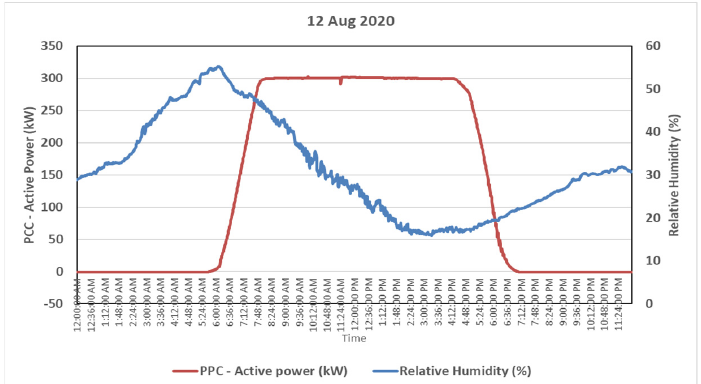
Figure 19. Active power vs. relative humidity on a moderately humid day.